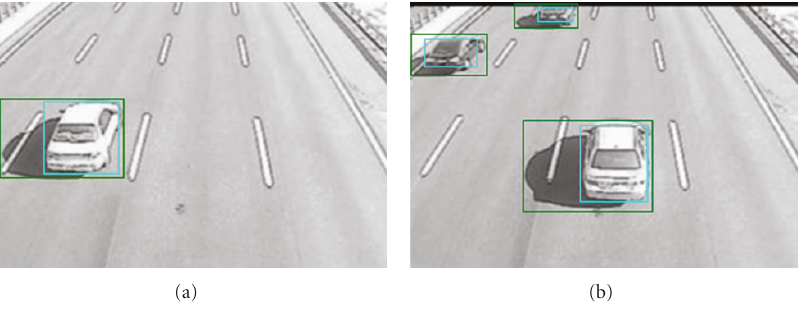
Figure 25: Examples of final located real objects.